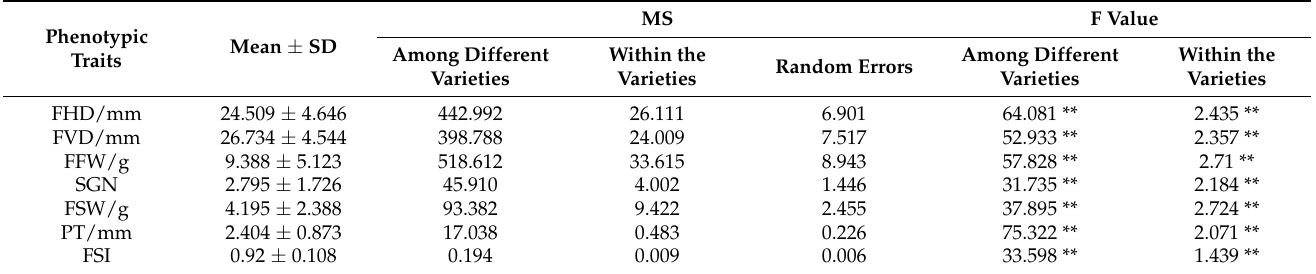
Table 3. Analysis of phenotypic variance among different varieties and within varieties of germplasm resources of C. oleifera in